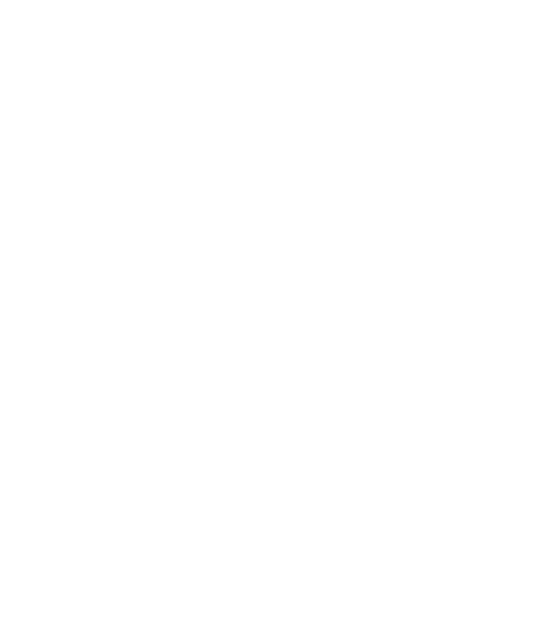
Table 1-A1 continues in the next column →